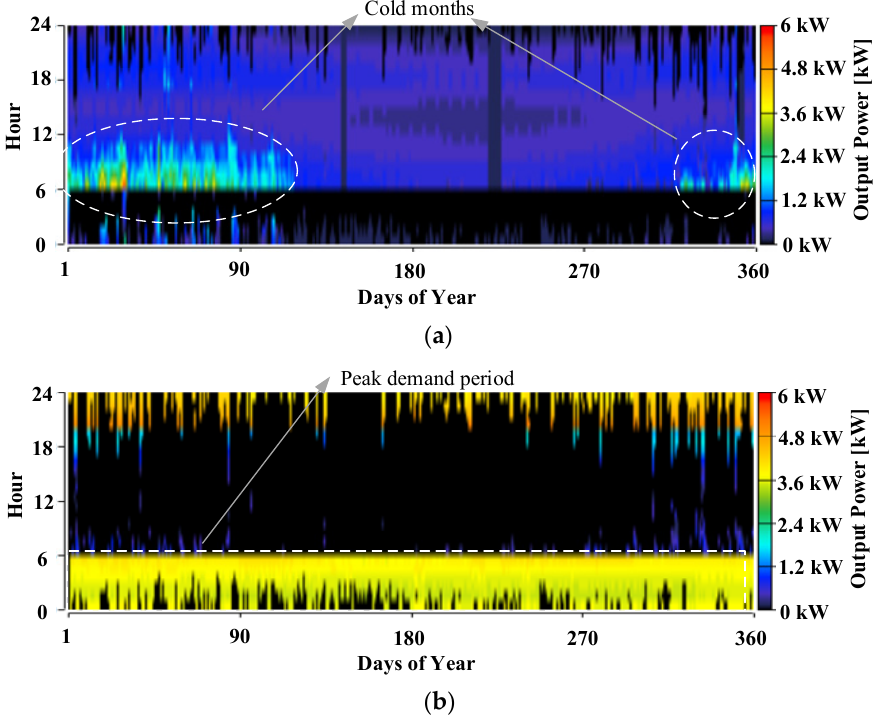
( b ) Figure 14. The ESS state of charge: ( a ) in hourly scale; ( b ) in monthly scale. Figure 15 indicates the thermal energy provisions by boiler and FC. The boiler is the main supplier of thermal energy. Nevertheless, the FC is incorporated in supplying the loads in peak demand periods. The boiler produces more power during cold months. Due to the lack of TLC in the system’s structure, the extra generation of the PV system cannot